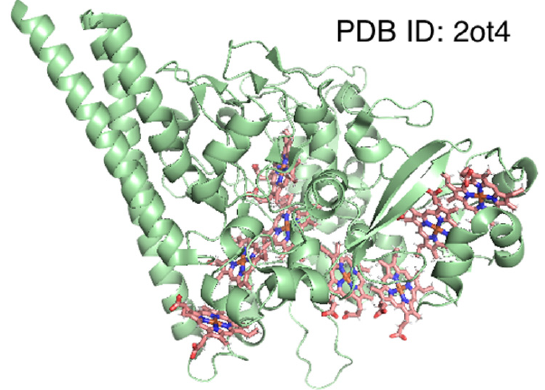
Figure 6. Structure of eight-heme nitrite reductase. The protein backbone is represented as a green cartoon, and hemes are shown as stick models.